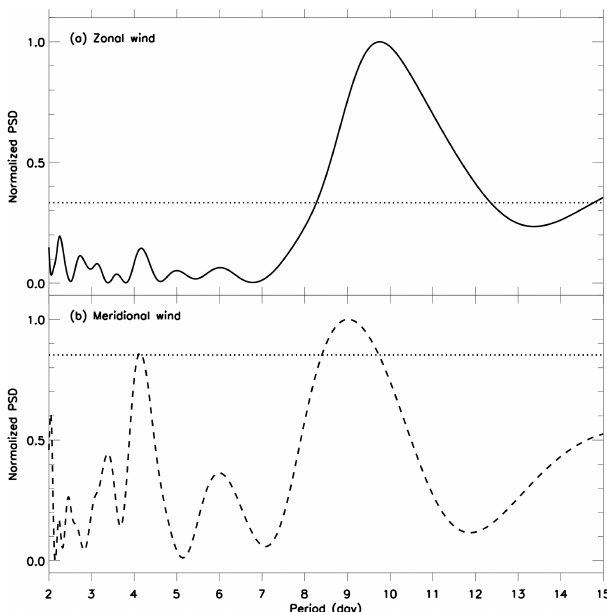
Figure 13. Lomb–Scargle periodogram for (a) zonal and (b) merid- ional wind during November 2013 at 93km altitude over Cachoeira Paulista. Horizontal dotted line represents a significance level of 95%, i.e., false alarm probability of